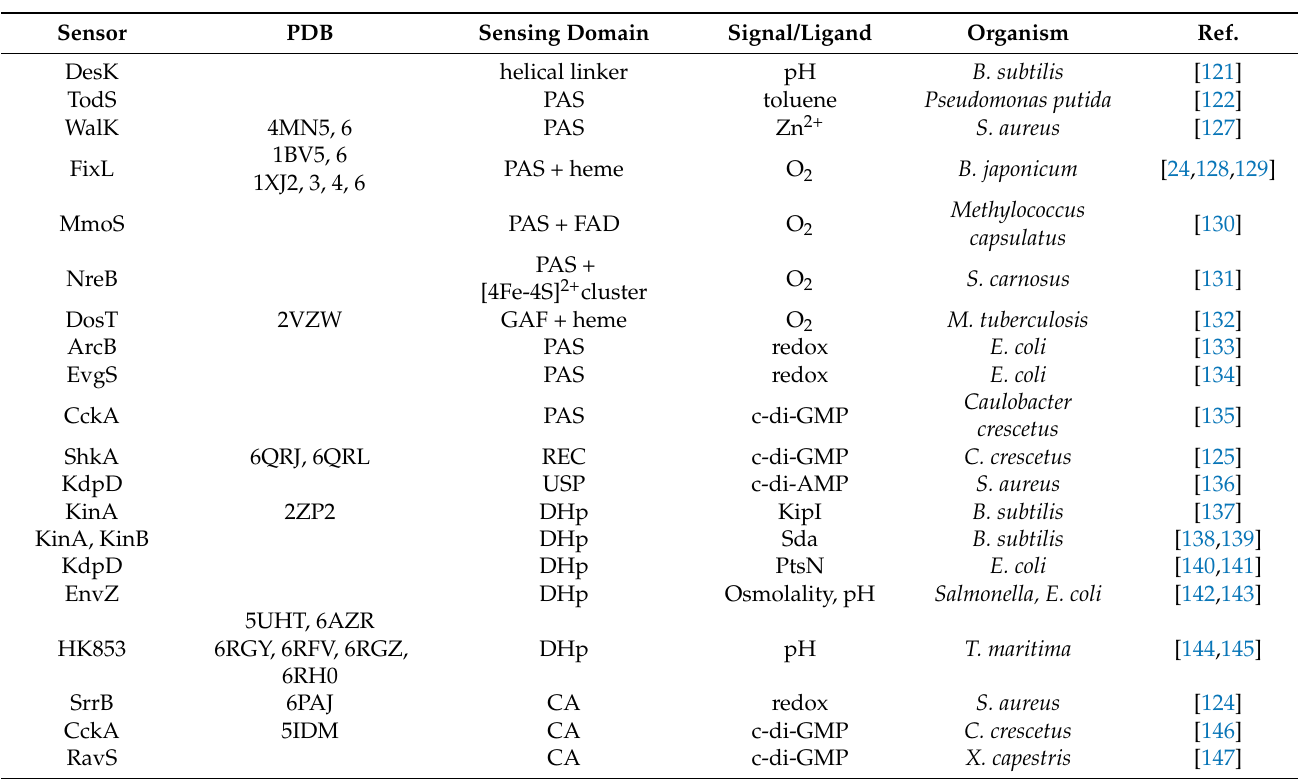
Table 2. Examples of cytoplasmic-sensing domains and their